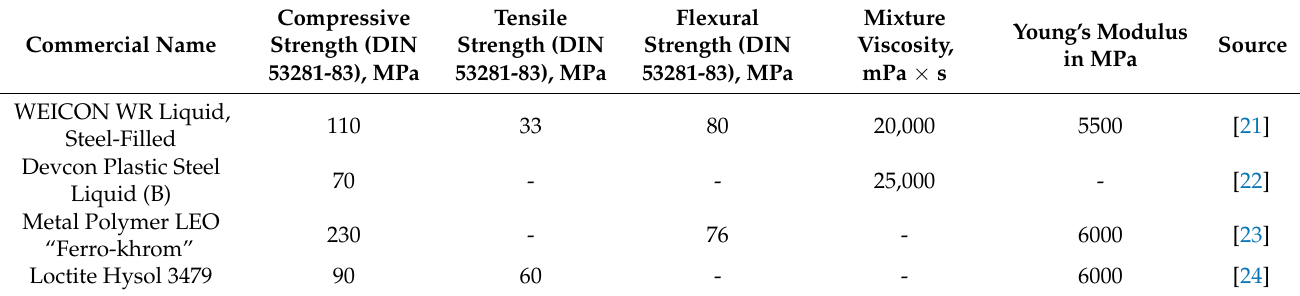
Table 2. Properties of metal-polymer materials.